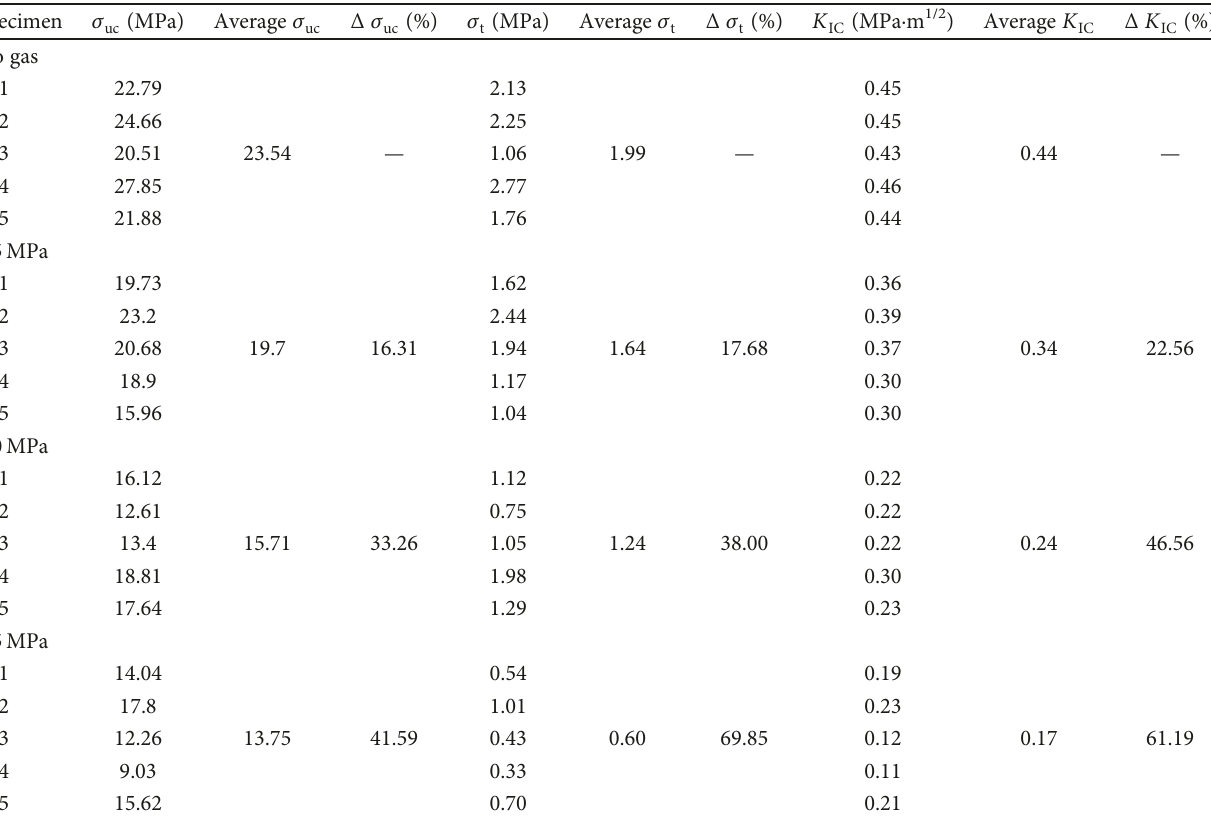
Table 1: Mean values of uniaxial compressive strength ( σ pressures.